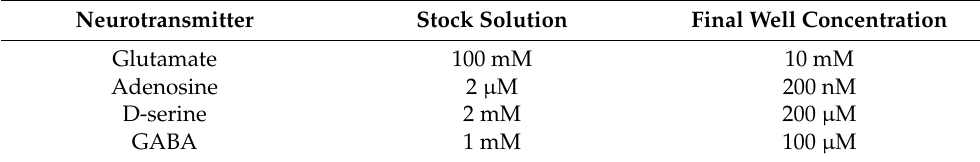
Table 1. Stock and final concentrations of neurotransmitters used in